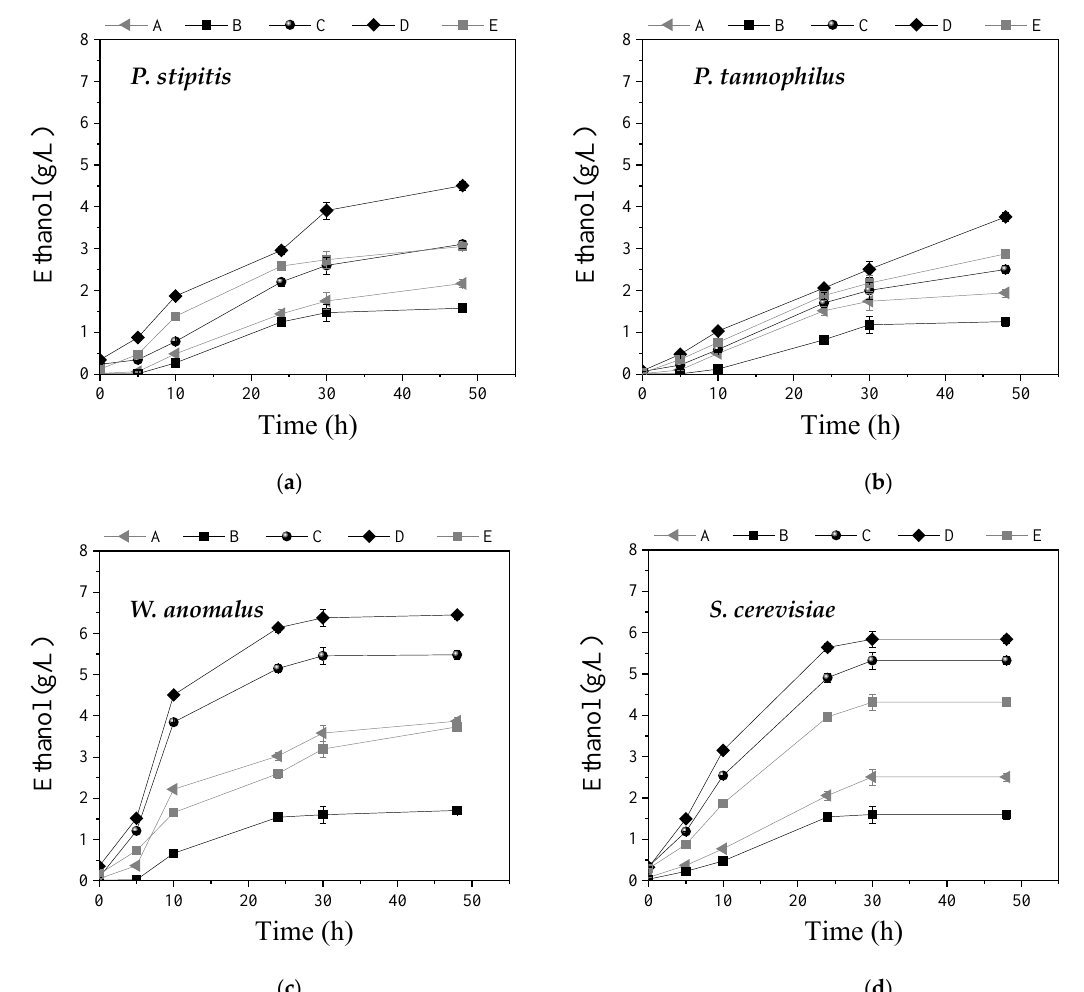
Figure 5. Ethanol concentration during batch mono-culture of ( a ) Pichia stipitis , ( b ) Pachysolen tannophilus , ( c ) Wickerhamomyces anomalus X19, and ( d ) Saccharomyces cerevisiae for the fermentation of the whole slurry after pretreatment with (A) NaOH (0.5% w / v ), (B) H 2 O 2 (0.5% v / v ), (C) mixture of NaOH (0.5% w / v ) and H 2 O 2 (0.5% v / v ) at ratio 1:1, (D) initially NaOH (0.5% w / v ) followed by H 2 O 2 (0.5% v / v ), and (E) initially H 2 O 2 (0.5% v / v ) followed by NaOH (0.5% w / v